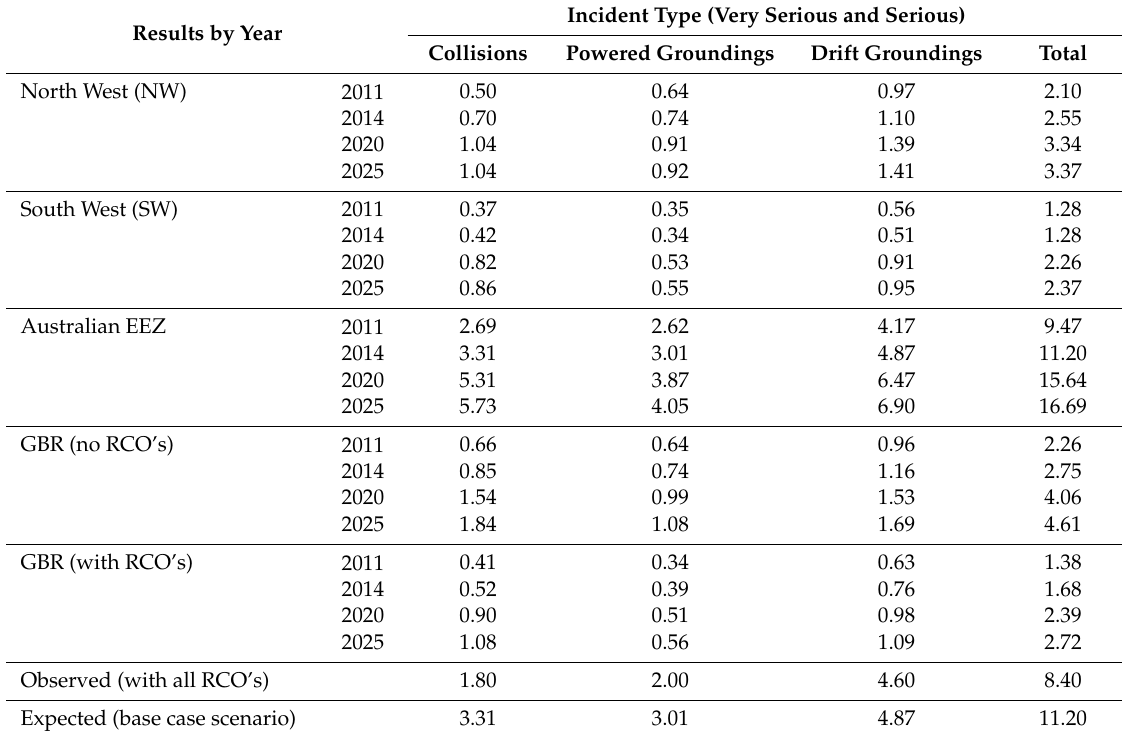
Table 2. Expected numbers of incidents by regions and year (base case year = 2014).